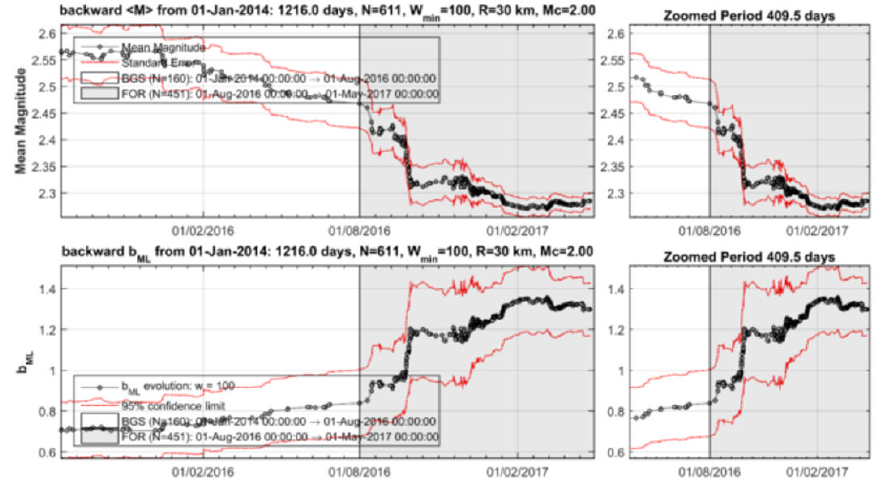
Figure 11. Time variation of the mean magnitude < M > (upper panel) and b (lower panel) for M c ≥ 2.0 during the seismicity stage BGS 1 and the hypothetical foreshock activity (cluster 1) within radius R = 30 km from the 2018 mainshock